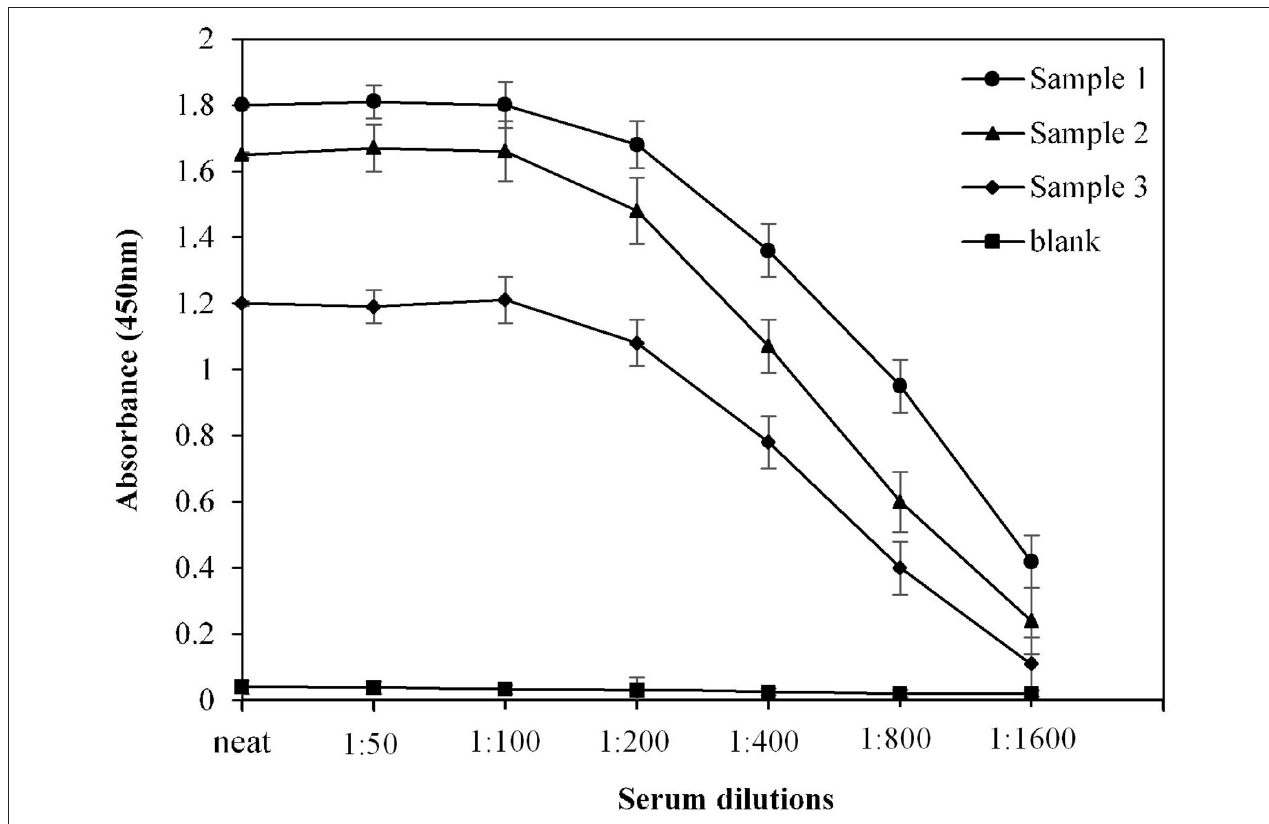
FIGURE 2 | Optimization of serum dilution for ELISA. Serum samples from COVID-19 convalescent individuals ( n = 3) were used in the assay. Each sample was run in triplicate under similar conditions.